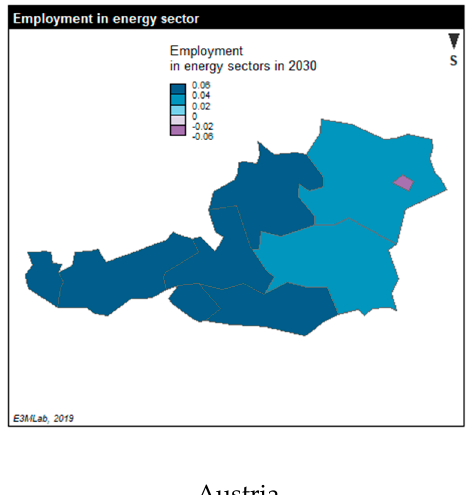
Figure 6. Percentage change in employment in energy industries relative to the base case in 2030.